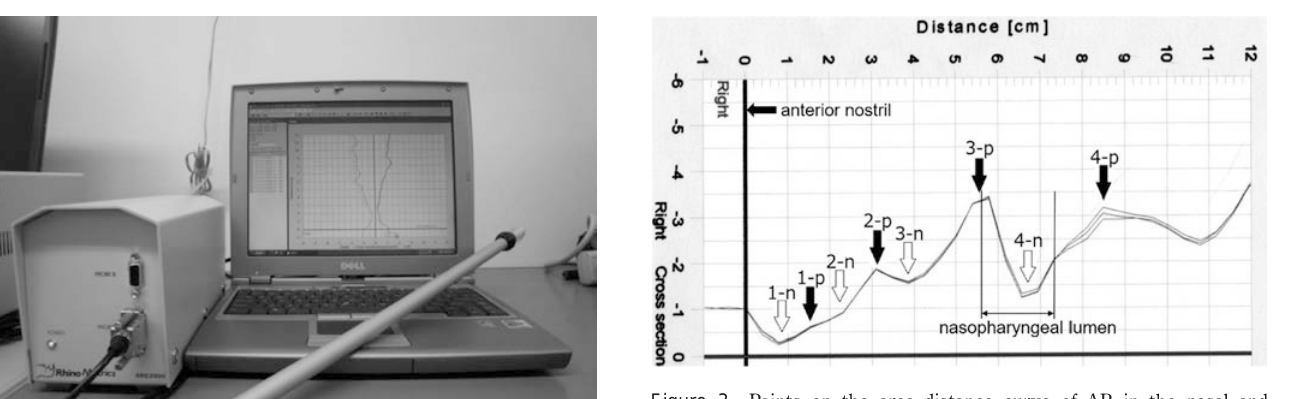
Figure 3 Points on the area–distance curve of AR in the nasal and nasopharyngeal model without simulated obstacles. The first dip from the anterior nostril of the area–distance curve was defined as the first notch (1-n), the following peak as the first peak (1-p), and so on, to the fourth peak (4-p) in order.